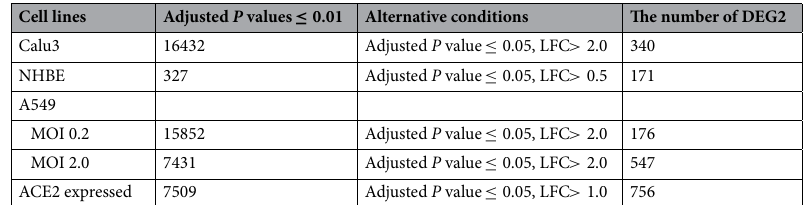
Table 9. The number of DEGs in SARS-CoV-2 study by DESeq2 (based on author-provided supplementary